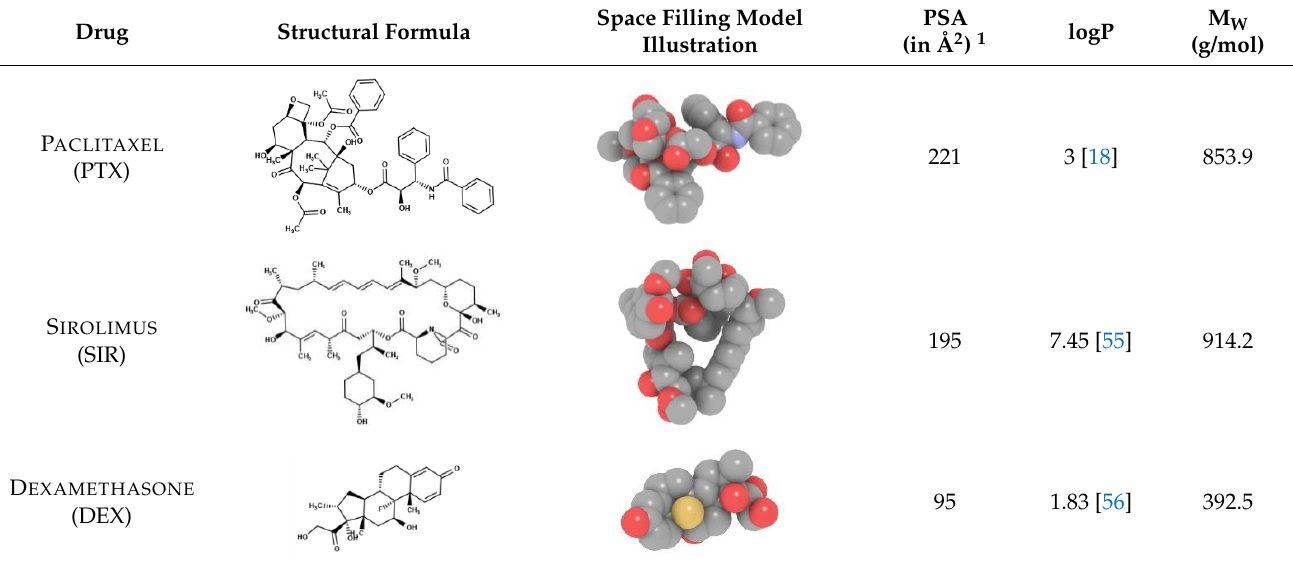
Table 2. An overview concerning the drugs used in this study for blending with PLLA and their selected properties. Drug Structural Formula